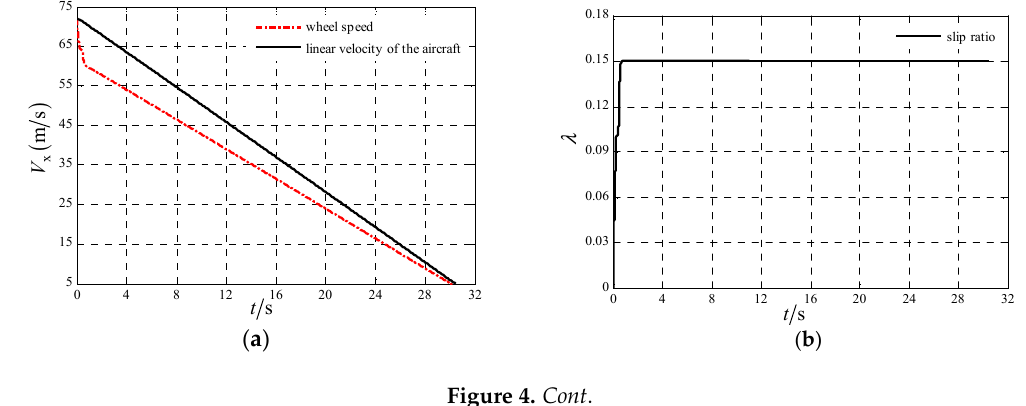
( c ) Figure 4. Simulation results of proposed method . ( a ) Aircraft speed and wheel speed; ( b ) Slip ratio; ( c ) Braking pressure. The braking process time is 30.6 s with the braking distance of 1139 m. From the simulation results, it can be seen that the optimal slip rate is well tracked. There is no significant overshoot, and the braking pressure is kept stable. Moreover, the braking system works in a small range on both sides of μ max . 4.2. Hardware In Loop (HIL ) Experiment In order to verify the brake actuator pressure servo performance, a sine wave emitted by the function signal generator for motor drive controller is used as brake pressure reference signal. An oscilloscope is also used to record the brake pressure feedback signal. The output of the signal from the pressure sensor is then amplified and filtered by the signal conditioning circuit in order to observe the performance in an easy way. The HIL system structure is shown in Figure 5. ω A P x v x v  * A P Figure 5. Structure of the HIL experimental platform. The hardware of the HIL test bench is composed by an anti-skid braking controller, the EMA and the aircraft wheel. The software includes the upper computer and the simulation unit. The aircraft model is built by RT-LAB and downloaded to the target board to achieve the simulation of